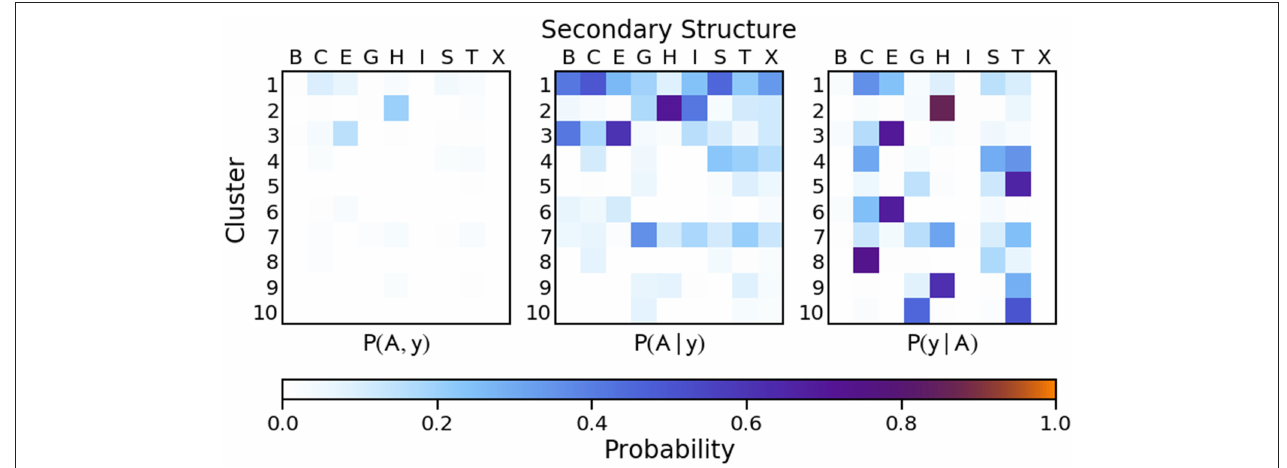
FIGURE 8 | Joint and conditional probabilities for the PAMM clustering of the first two principal components of the reduced SOAP vectors describing each residue of the protein backbone, where A is the PAMM cluster assignment and y is the DSSP secondary structure classification.